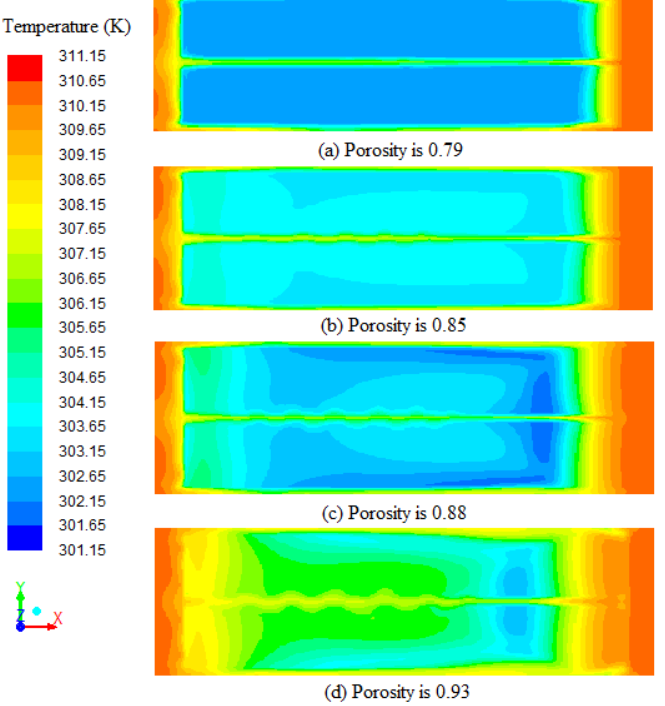
Figure 12. Temperature profiles on the cross-section (0.8 m from ground) at 3000 s with different porosities (a = 0.79, b = 0.85, c = 0.88, and d = 0.93) of porous zones.